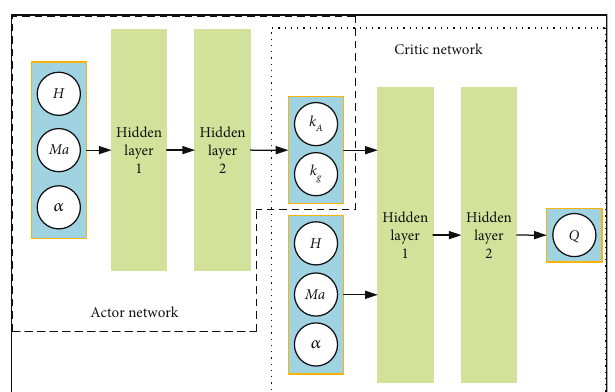
Figure 7: TD3 algorithm network layer